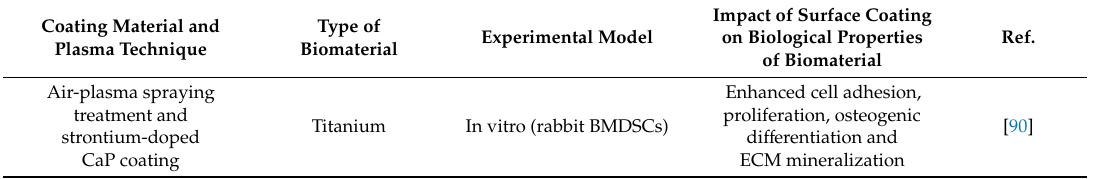
Table 3. Surface modifications of biomaterials using coating materials and